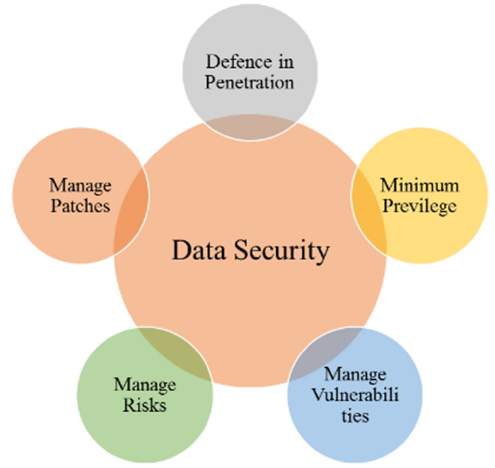
Figure 6. Data security components.